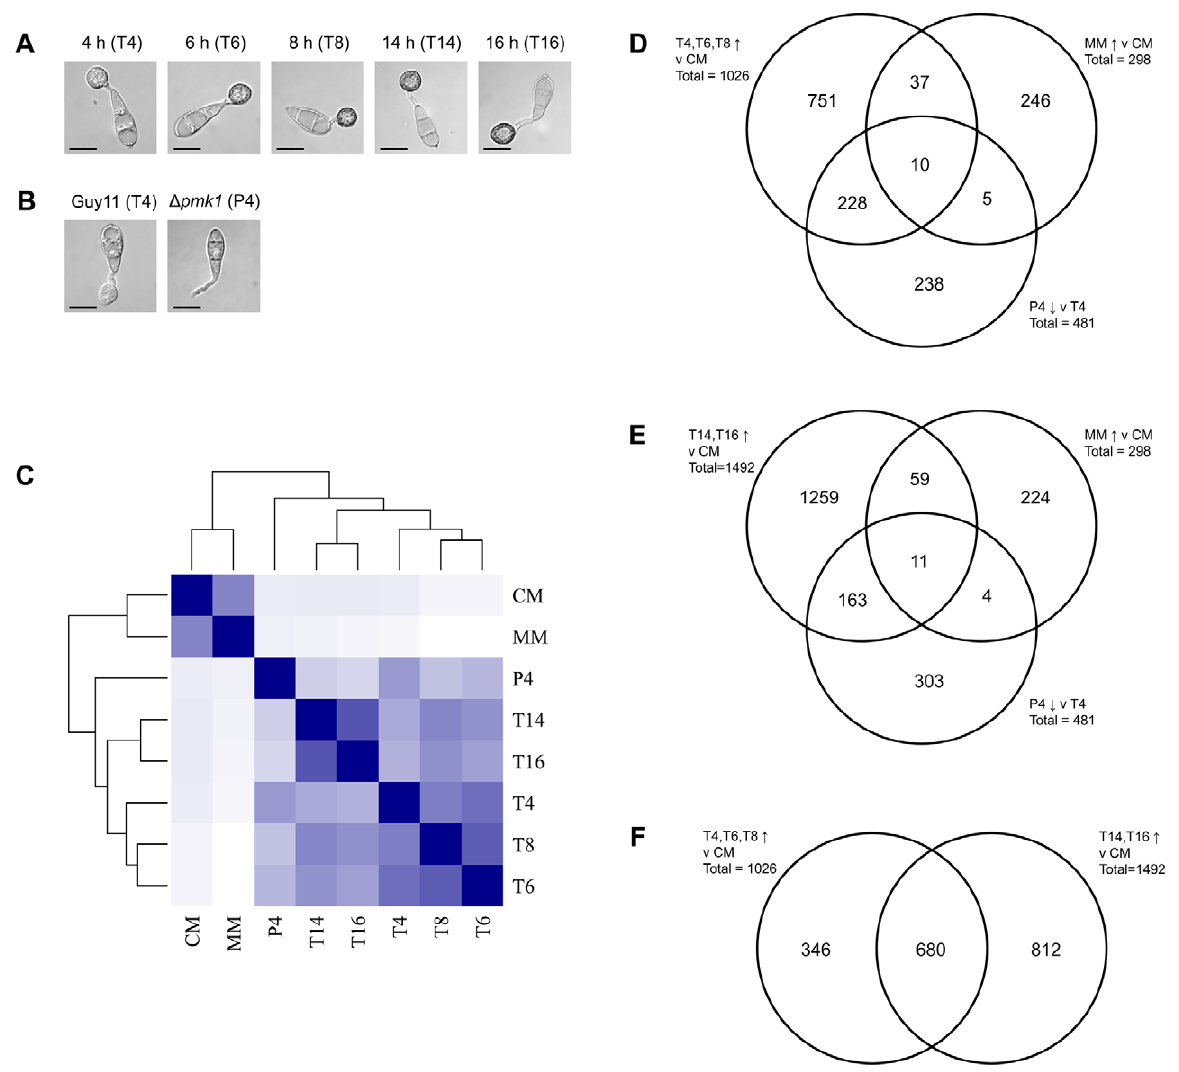
Figure 1. Overall comparison of HT-SuperSAGE datasets. A . Micrographs showing appressorium development at time-points used for HT- SuperSAGE analysis (scale bar=10 m m). B . Micrographs comparing appresorium development at 4 h in wild-type Guy11 and D pmk1 mutant backgrounds. C . Heatmap showing Euclidean distances between HT-SuperSAGE samples as calculated from a variance-stabilising transformation of the total count data. The darker the colour, the closer the two datasets are together. T4, T6, T8, T14 and T16 are time-points during appressorium development in Guy11, P4 is appresorium development at 4 in a D pmk1 mutant. CM and MM are samples from Guy11 mycelium grown in complete medium and minimal medium respectively. D . Venn diagram illustrating overlaps between number of genes that are significantly up-regulated (P- value , 0.05) in early appressorium development – 4 h to 8 h (vs mycelium grown in CM), significantly up-regulated (P-value , 0.05) in mycelium grown in minimal medium (vs mycelium grown in CM) and significantly down-regulated (P-value , 0.05) in a D pmk1 mutant compared to Guy11 after 4 h E . Venn diagram illustrating overlaps between number of genes that are significantly up-regulated (P-value , 0.05) in late appressorium development – 14 h to 16 h (vs mycelium grown in CM), significantly up-regulated (P-value , 0.05) in mycelium grown in minimal medium (vs mycelium grown in CM) and significantly down-regulated (P-value , 0.05) in a D pmk1 mutant compared to Guy11 after 4 h. F . Venn diagram illustrating overlaps between number of genes that are significantly up-regulated (P-value , 0.05) in early appressorium development – 4 h to 8 h (vs mycelium grown in CM) and late appressorium development – 14 h to 16 h (vs mycelium grown in CM). doi:10.1371/journal.ppat.1002514.g001 metabolism, specifically the large and diverse set of glycosyl twelve of these genes into a clade showing up-regulation during early stages of appressorium formation. Infection-associated autophagy is necessary for appressorium function and deletion of any one of sixteen genes involved in non-selective macroauto- phagy in M. oryzae leads to loss of pathogenicity [9]. A total of 1492 genes were identified as significantly up-regulated (adjusted P- value , = 0.05) at both 14 h and 16 h, when compared to mycelium grown in CM (Table S2). GO categories over- regulated by the presence of an active PMK1 MAP kinase represented in this dataset included those involved in carbohydrate